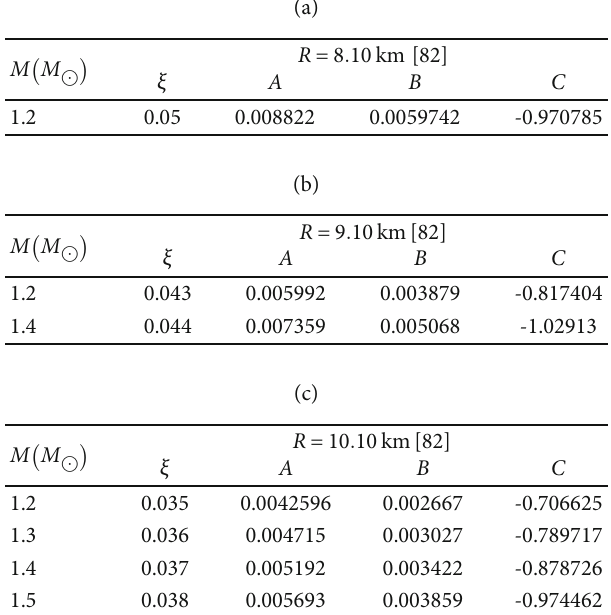
Table 1: Constant values of ξ , A , B , and C for considered compact